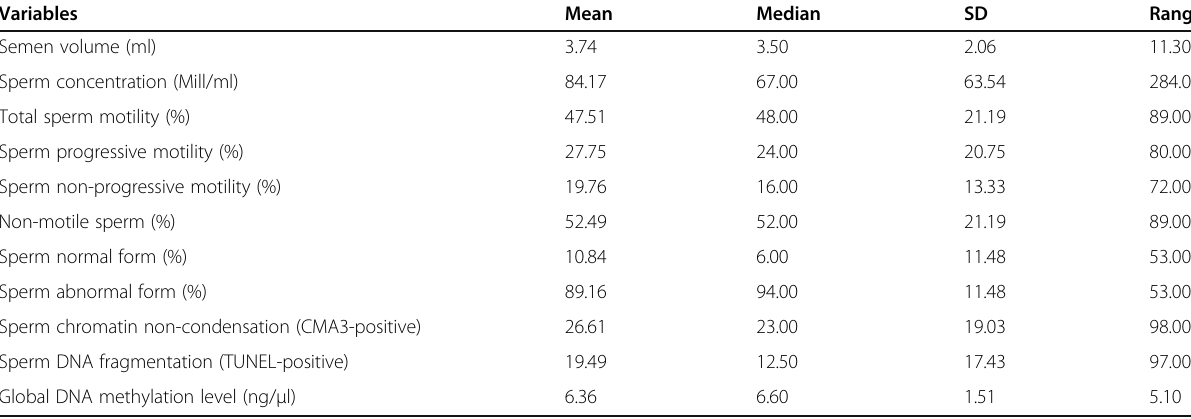
Table 1 Descriptive characteristics of the study population ( n = 188)